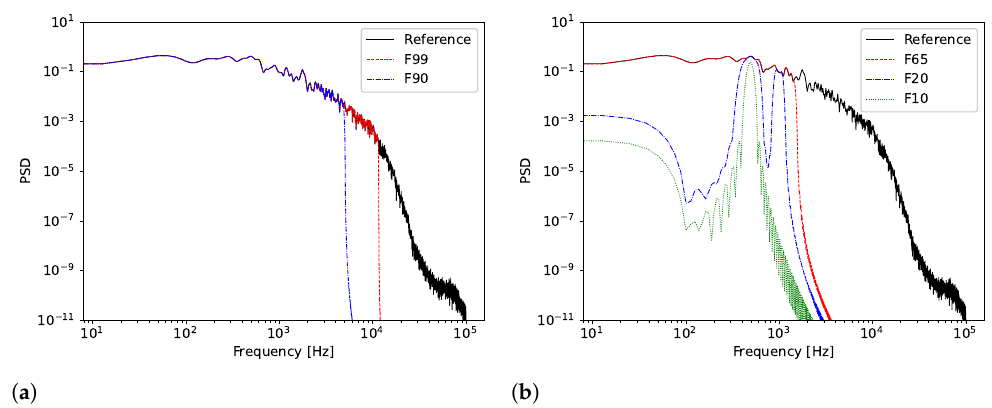
Figure 15. Power spectral densities of the axial velocity signal of a probe located at the center of the inlet plane (green plane of Figure 11). ( a ) F99, F90. ( b ) F65, F20, F10.